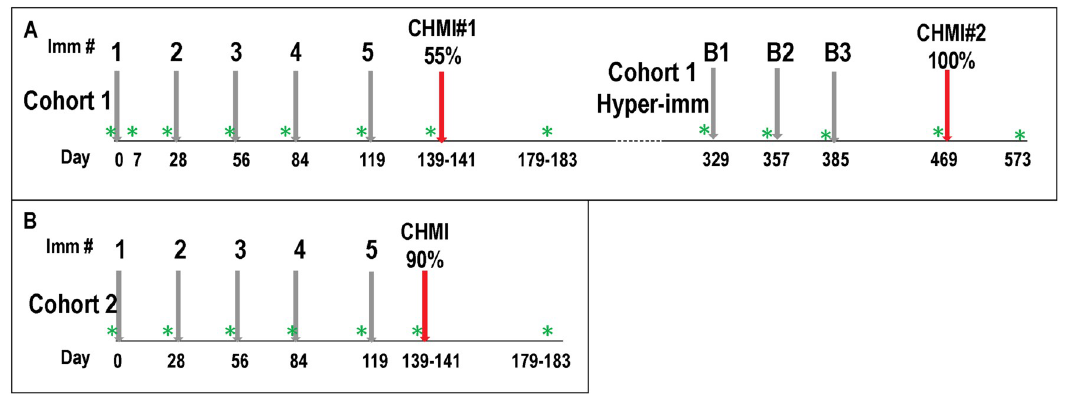
Fig 1. Cohort 1 and Cohort 2 and Cohort 1 hyper-immunized: Flow diagram of immunizations, CHMI and PBMC samples. Panel A : Cohort 1 received four monthly immunizations (1, 2, 3, 4) and a fifth immunization (5) 33 days later; 11 subjects received their first CHMI (CHMI#1) 22–24 days post-5 th ; four protected subjects from Cohort 1 were hyper-immunized and received three monthly boosting immunizations (B1, B2, B3) starting 329 days post-1 st , and three subjects received CHMI#2 on days 472 post-1 st . Six/11 (55%) immunized subjects were protected against CHMI#1, and three/three (100%) hyperimmunized subjects were protected against CHMI#2. Panel B : Cohort 2 followed the same schedule as Cohort 1, and nine/10 (90%) immunized subjects were protected against CHMI. PBMC were taken at times indicated (Green asterisk) that were just prior to each immunization and CHMI, and 38 to 44 days post-CHMI, except an additional sample was taken at 7 days post-1 st only in Cohort 1.